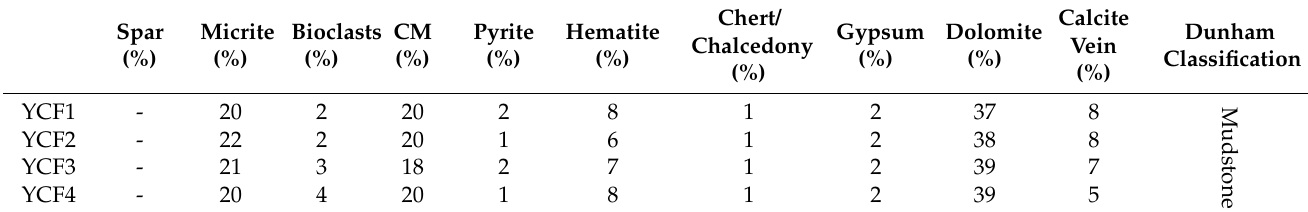
Table 2. Modal mineralogical composition of the Early–Middle Eocene carbonate rocks of Yadgaar